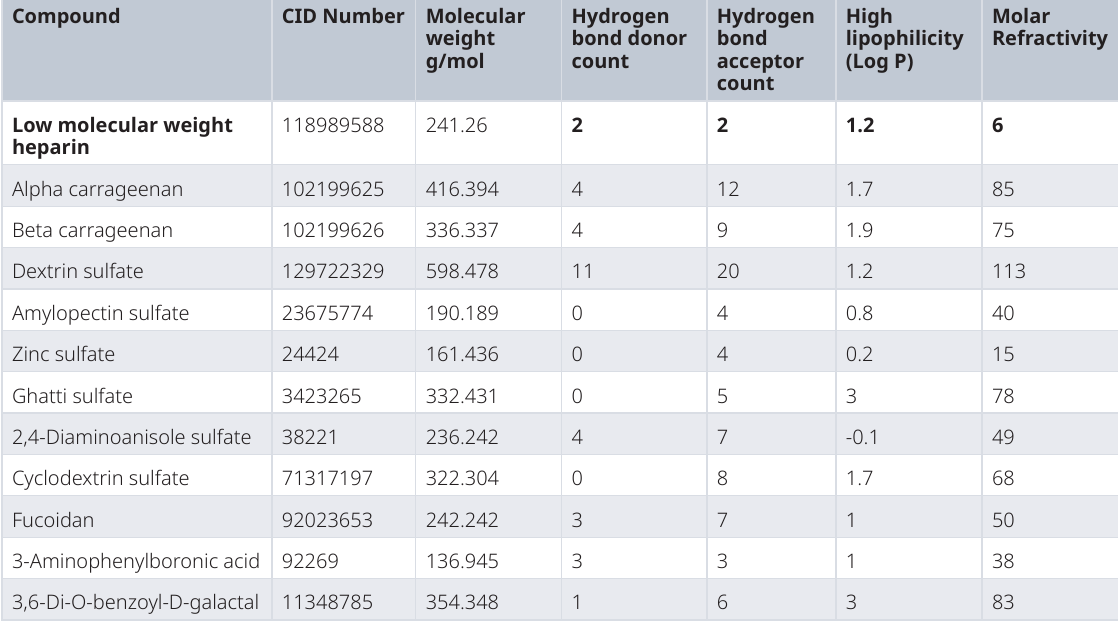
Table 6. Screened sulfated polysaccharides searched from PubChem database. Accession numbers, physical properties and Lipinski Rule of Five properties of each compound are curated. The Lipinski rule of five requires that a drug compound meets all the properties or deviates with at most one property. All the screened compound met the rules of a drug compound, except dextrine sulfate. Low molecular weight heparin included as a positive control. Compound